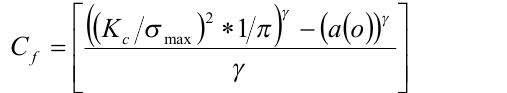
Table 4. Calculations of averages and STD for ln Q and a